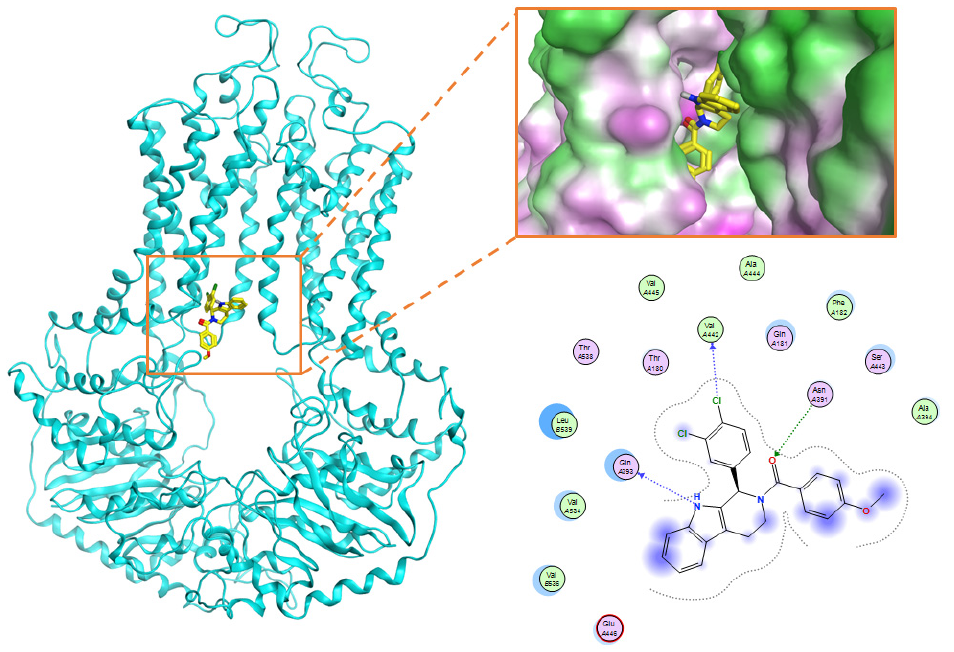
Figure 11. Binding site and interactions of JMC_2016_59_6121_51; DS = − 16.14 kJ · mol − 1 Figure 11 . Binding site and interactions of JMC_2016_59_6121_51; DS = − 16.14 kJ.mol − 1 .